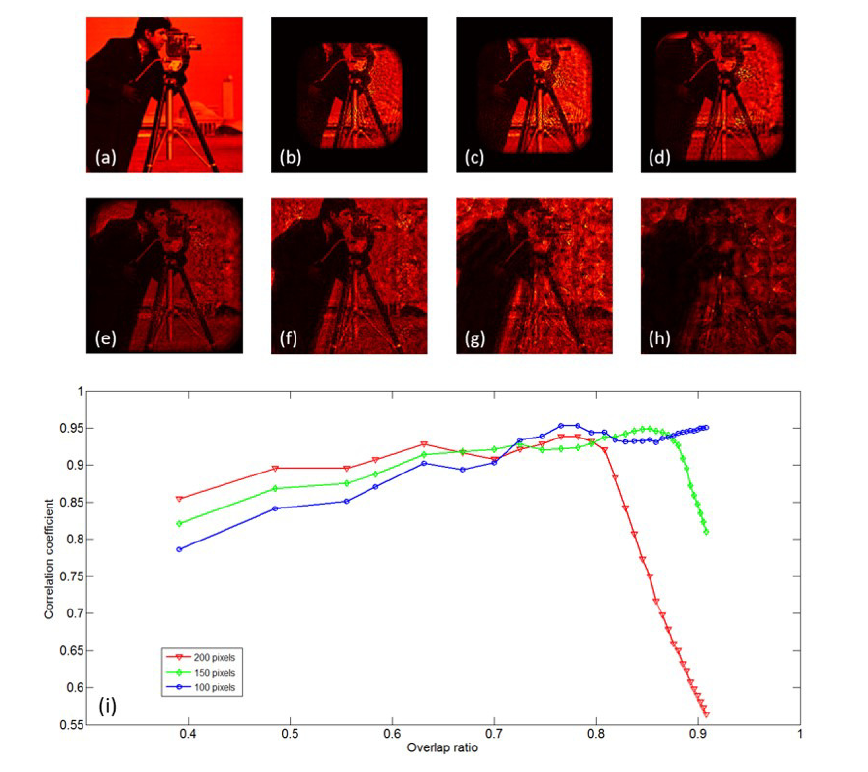
Figure 7. Effect of the overlap ratio of the probe beam to the reconstruction performance. ( a ) The target, ( b ) 90%, ( c ) 88%, ( d ) 86% , ( e ) 82%, ( f ) 75%, ( g ) 58%, and ( h ) 39%. ( i ) The correlation coefficient against a different overlap